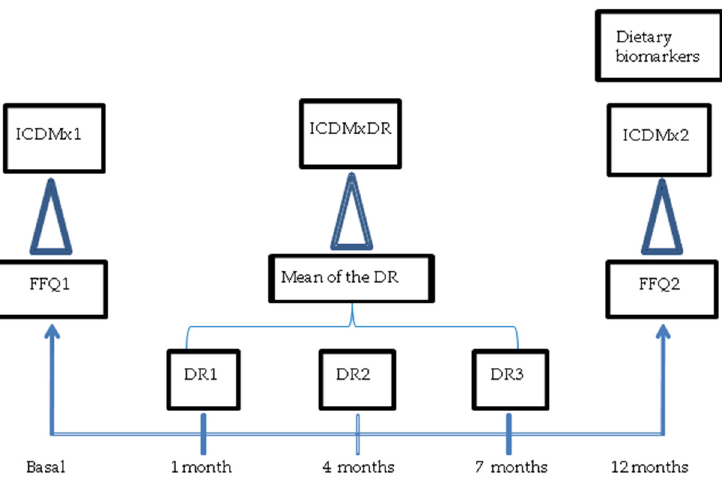
Figure 1. Data recollecting methodology. ICDMx, Índice de Calidad de la Dieta Mexicana ; FFQ, semi ‐ quantitative food frequency questionnaire; DRs, dietary records; FFQ1, basal FFQ; FFQ2, second FFQ (one year later); ICDMx 1, ICDMx from basal FFQ; ICDMx2, ICDMx from second FFQ (one year latter); ICDMxDR, ICDMx from DRs.